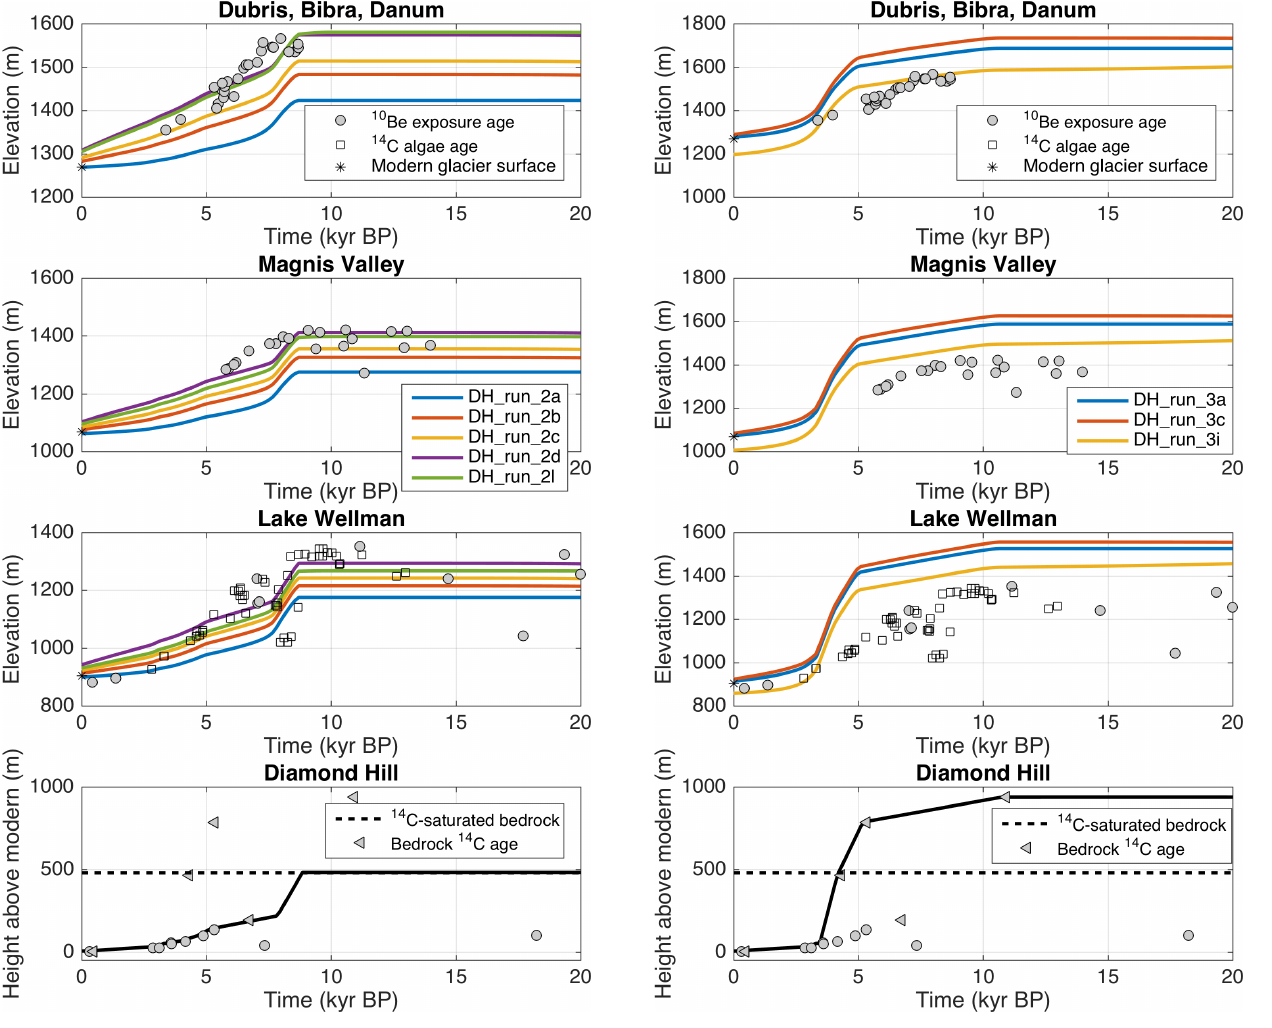
Figure 7. Flowband model results for Experiment 2. All inputs are the same as for Experiment 1, except for the downstream boundary condition, which contains a period of rapid deglaciation at 9–8ka. provides a better fit to the data.